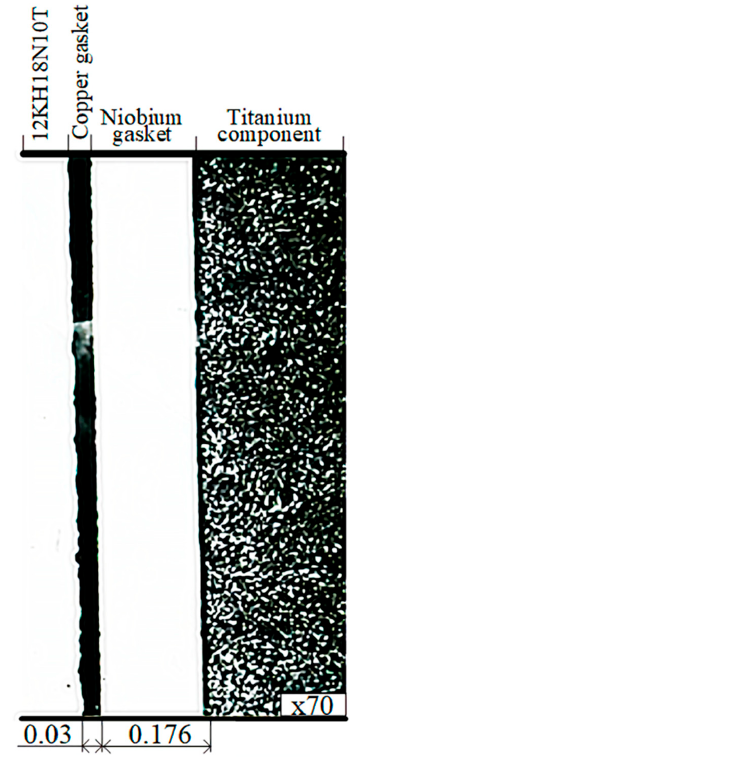
Figure 14. VT-14+Nb+Cu+12KH18N10T connection macrosection.